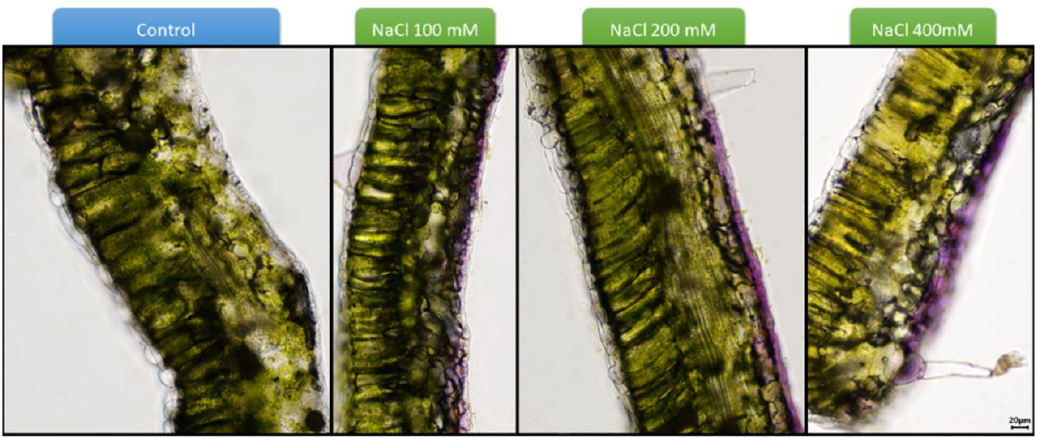
Figure 1. Vibratome transversal sections of tomato ( Solanum lycopersicum , Micro-Tom cultivar) leaves exposed to increasing concentrations of NaCl and showing anthocyanins in the epidermal layer of the abaxial side. Bar: 20 µm (same magnification for all the pictures).